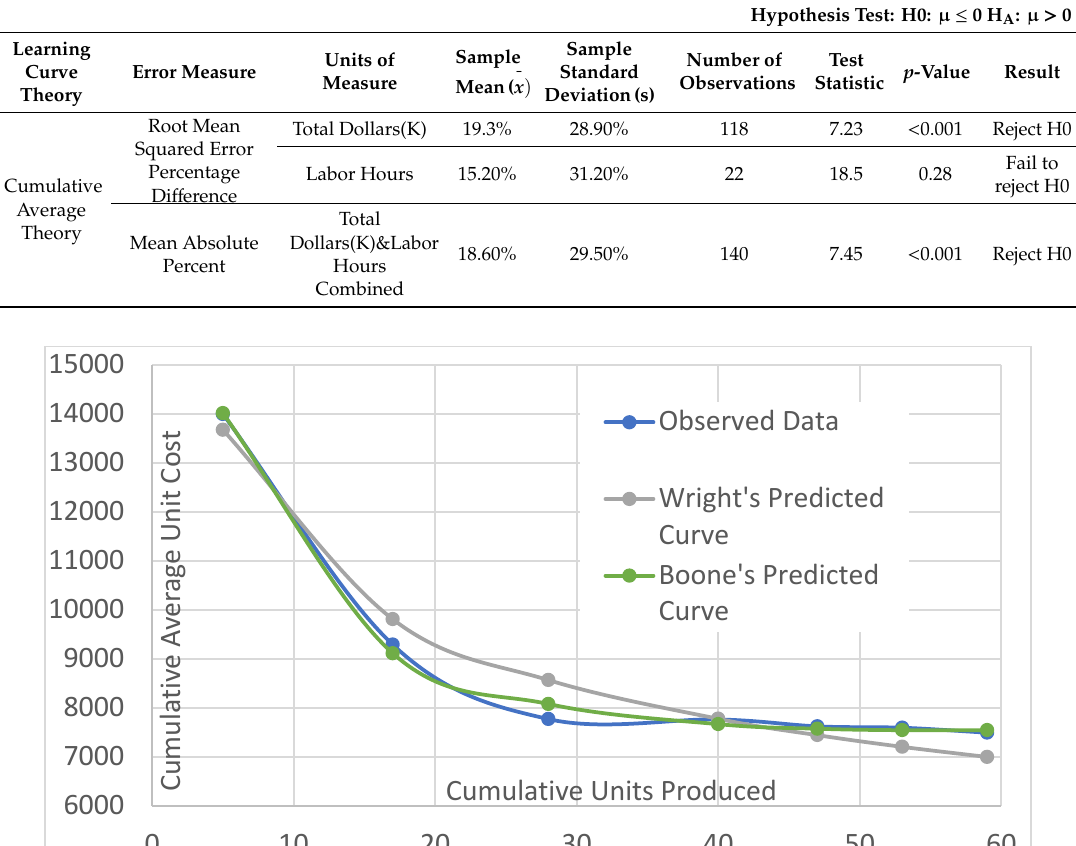
Table 2. Cumulative Average Theory Descriptive and Inferential Statistics.